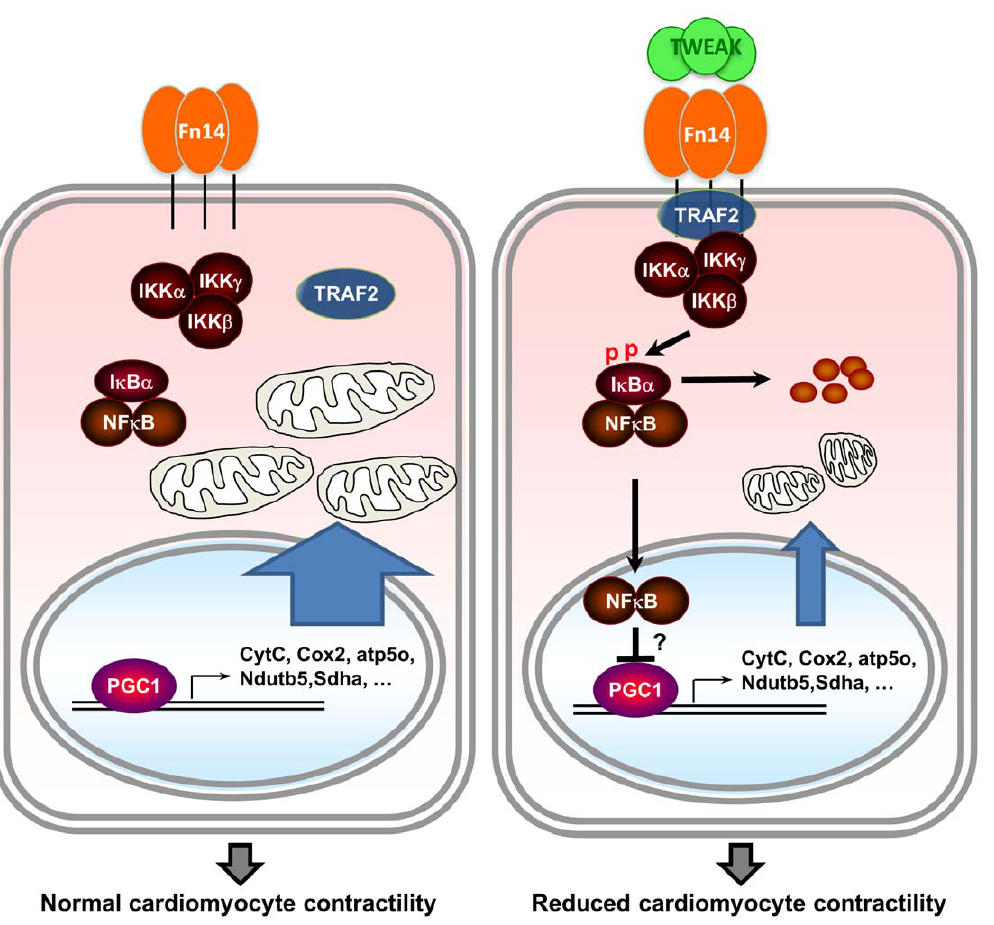
Figure 6. Graphical illustration summarizing the proposed mechanism underlying TWEAK-induced cardiac dysfunction. Normal PGC1 levels maintain OXPHOS gene expression and mitochodrial function to support cardiomyocyte contractility (left panel). TWEAK downregulates PGC1 levels through FN14-TRAF2-NF k B-dependent signaling, leading to impaired OXPHOS gene expression and mitochondrial dysfunction, and reduced cardiomyocyte contractility (right